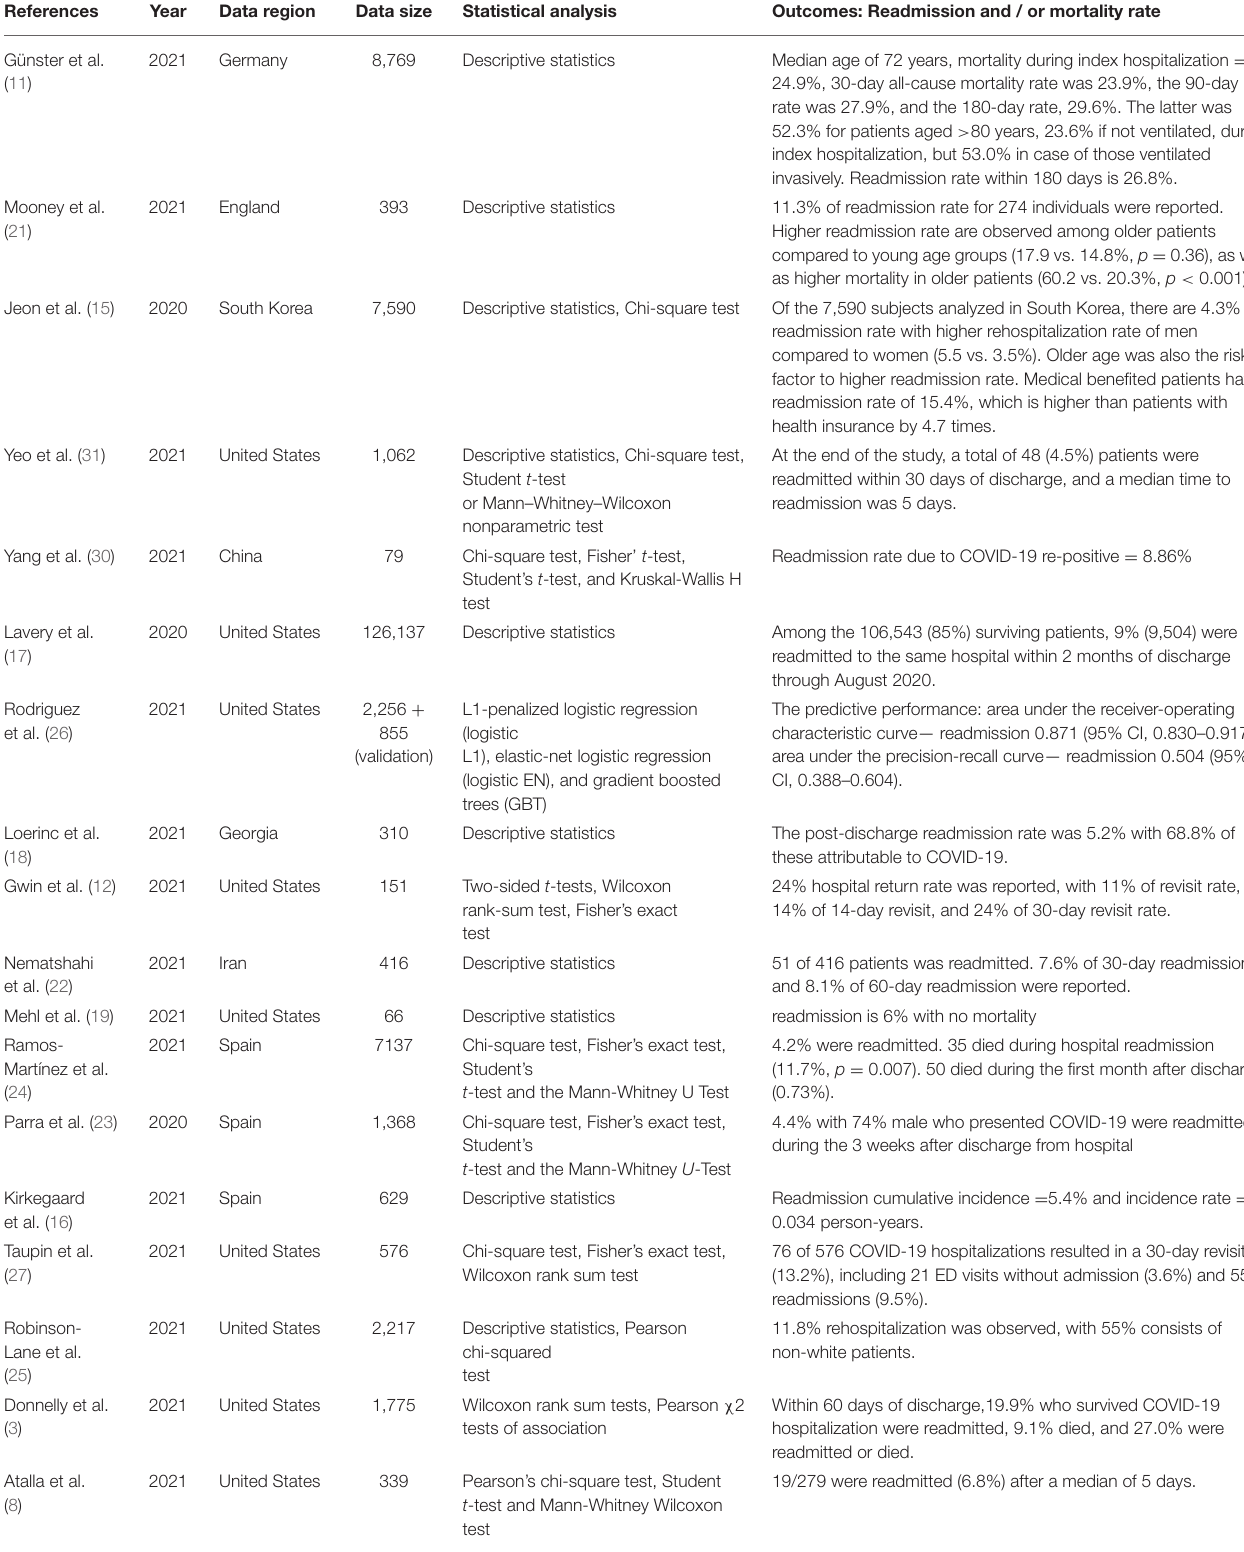
TABLE 2 | Table of review on readmission and / or mortality